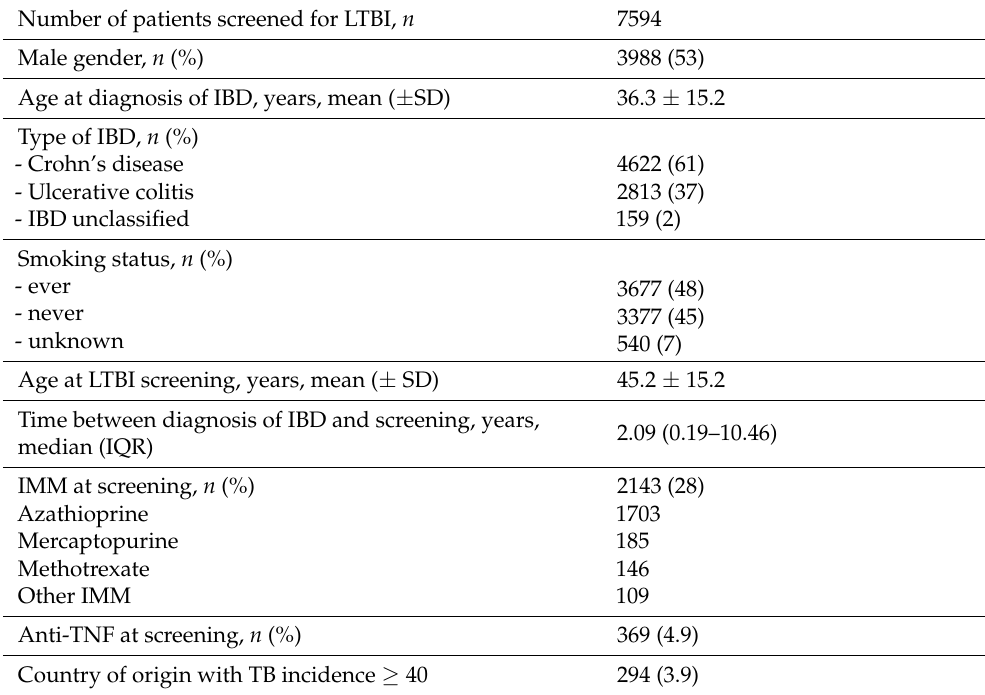
Table 1. Clinical and demographic characteristics of the cohort of patients with IBD who were screened for LTBI.